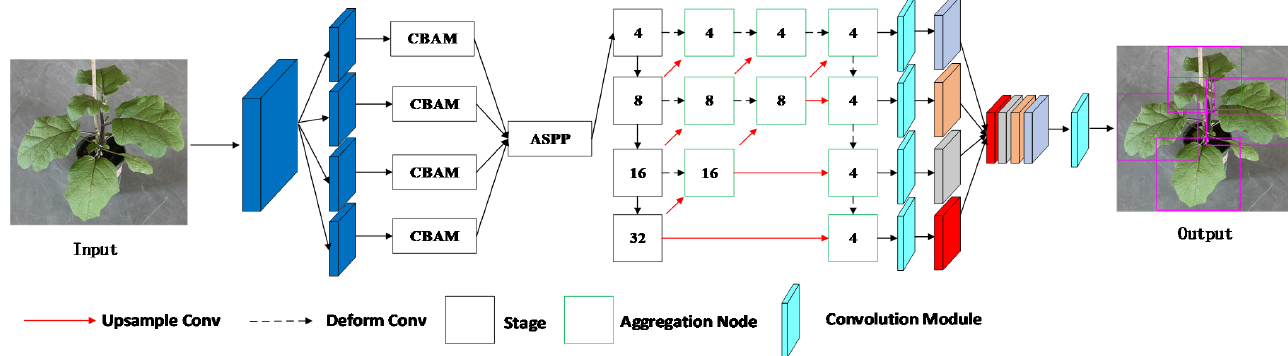
Figure 2. The improved network structure of CenterNet for detecting dense and overlapped leaves in plant canopy. The backbone network was sampled at different spatial resolutions to output feature maps. Each feature map had a specific spatial resolution and could be viewed as a stage. At each stage, the residual block method [32] was used to generate feature maps with different spatial resolutions, and obtain leaf features with different spatial